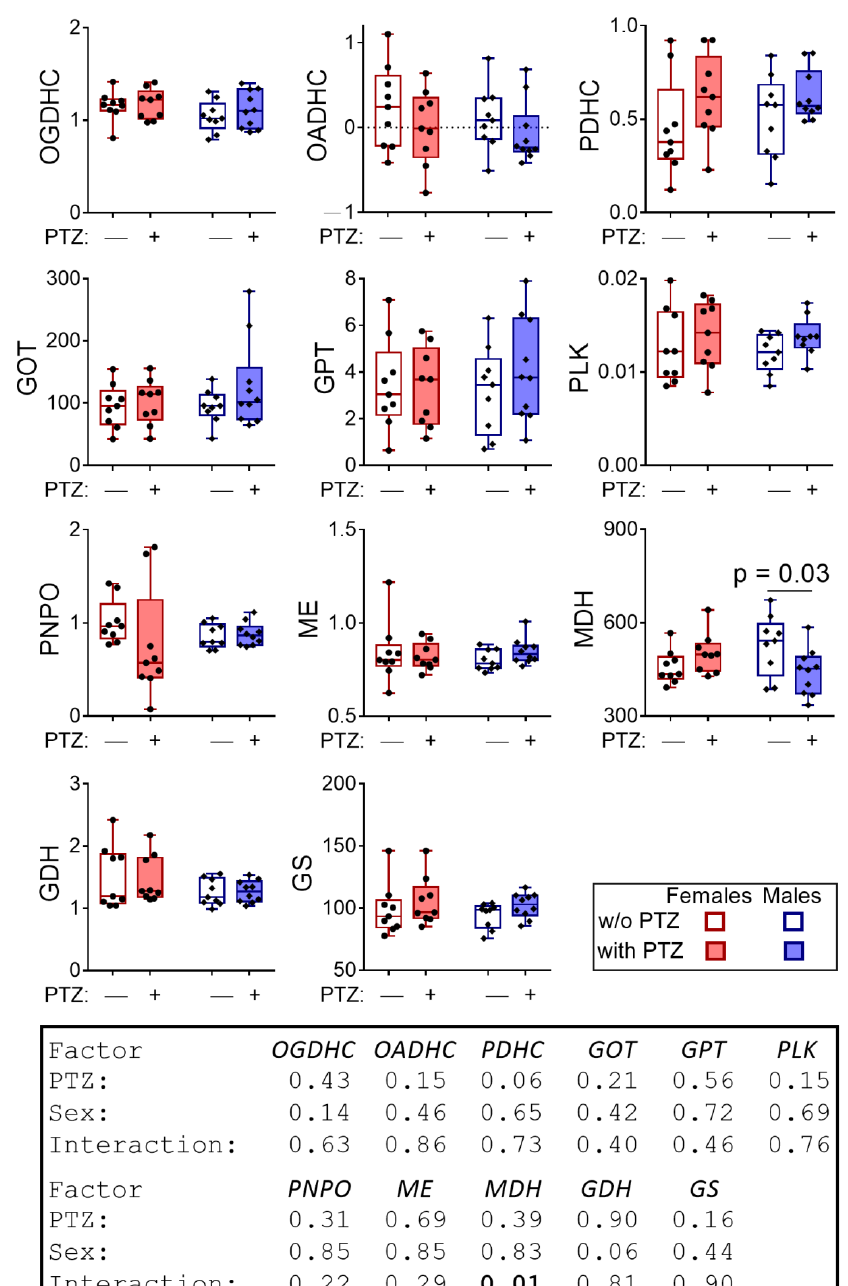
( p = 0.01, F(1,33) = 7.16) interaction of PTZ and sex regarding the MDH activity is revealed by two-way ANOVA, corresponding to the opposite directions of PTZ’s effects on MDH activity in the male and female rats (Figure 2).